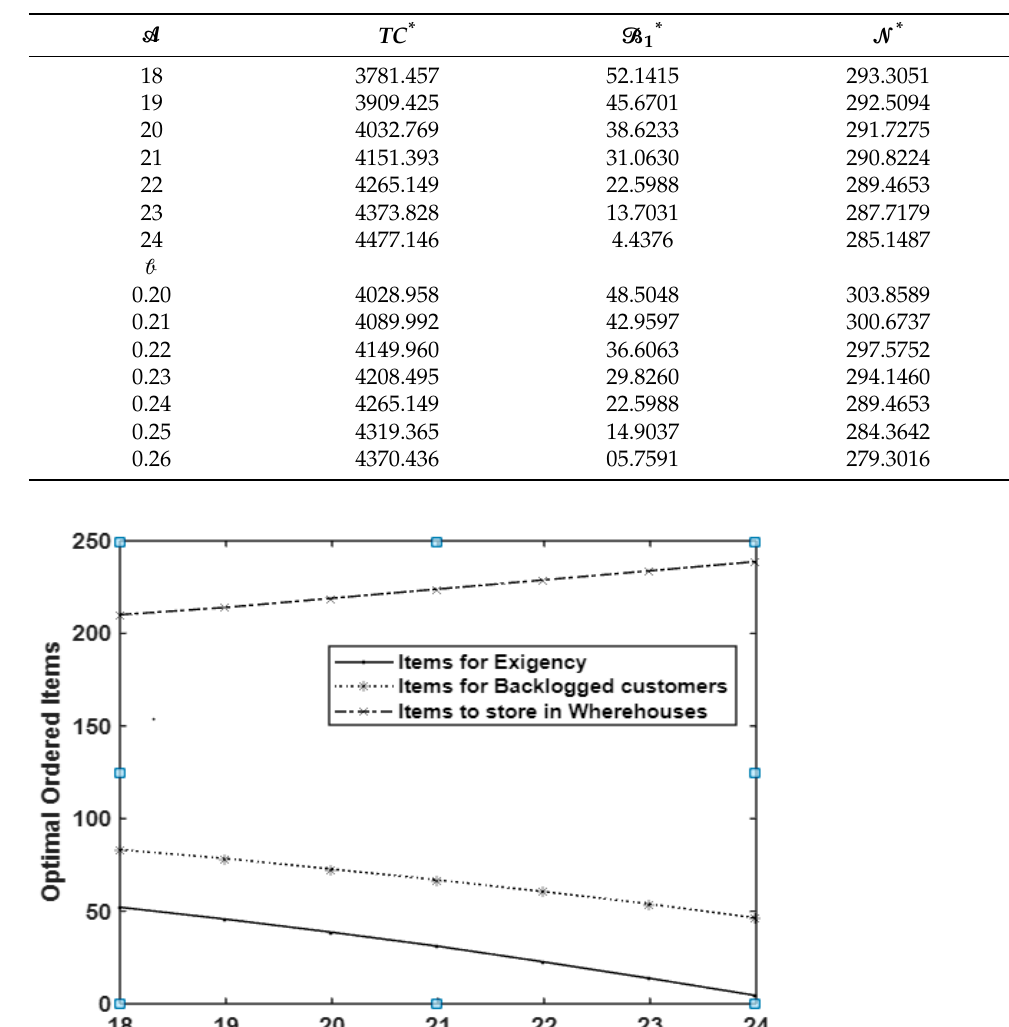
Table 2. The effect of changes in demand parameters (cid:65) and (cid:98) on arriving at optimal total cost and optimal ordering quantity.